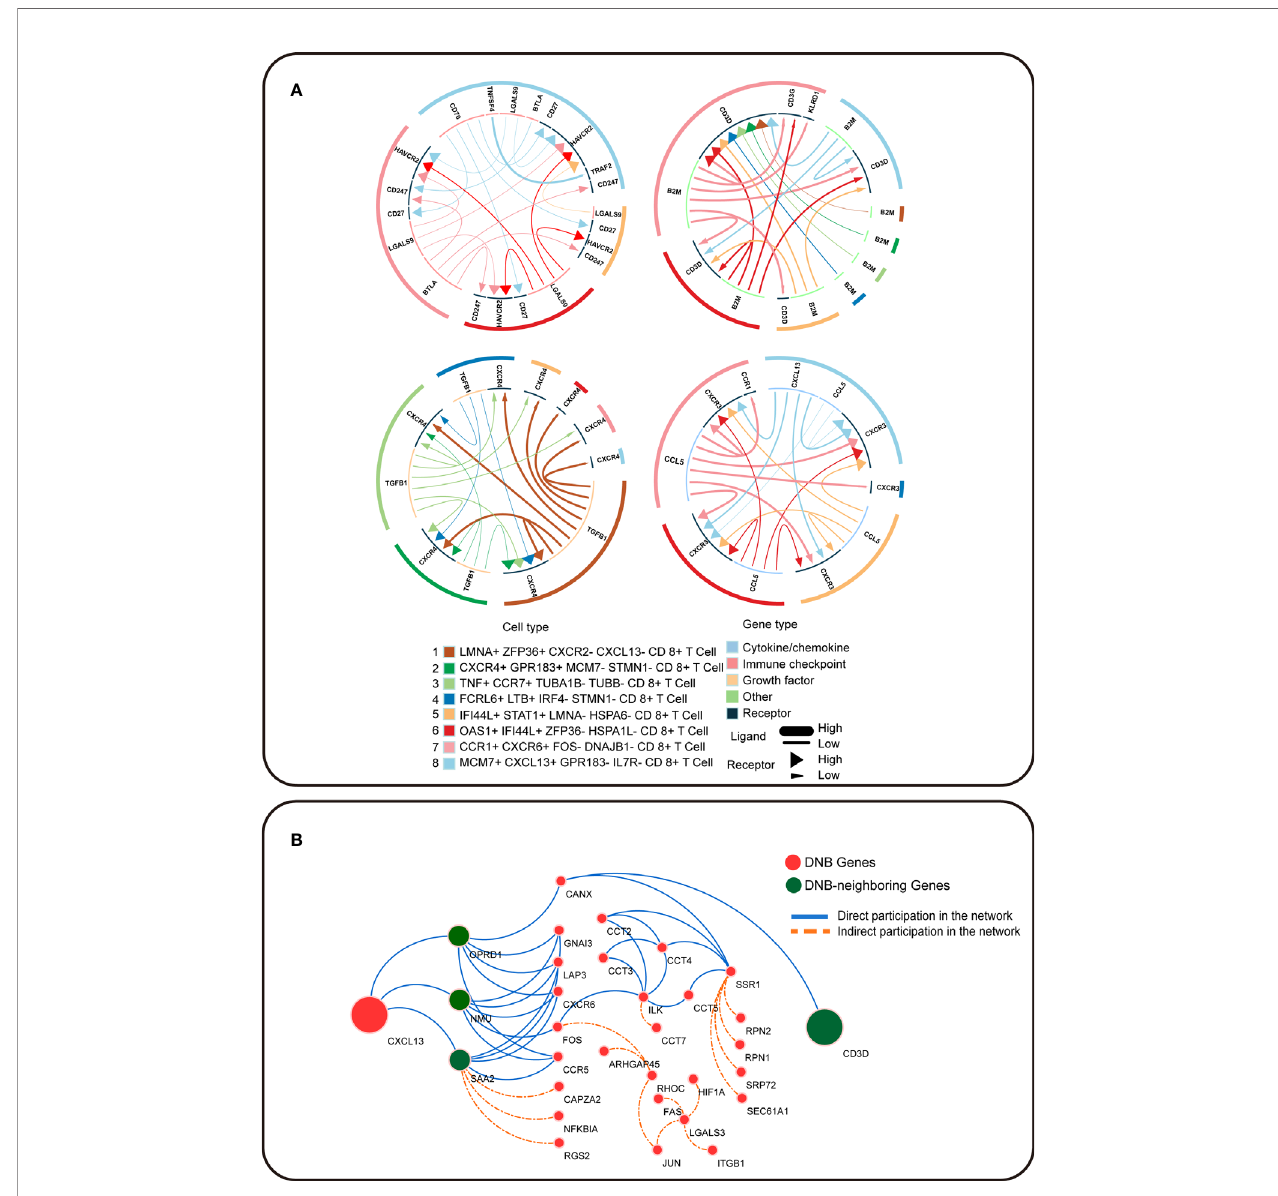
FIGURE 5 | Intercellular communication in T cell exhaustion. (A) The receptor – ligand pairs identi fi ed by iTALK. (B) Cytoscape visualization of the protein – protein interaction network in CRC. Red circles represent DNB genes, and green circles represent DNB-neighboring genes. The solid blue line represents genes that directly participated in the network, and the orange dotted line represents genes that indirectly participated in the